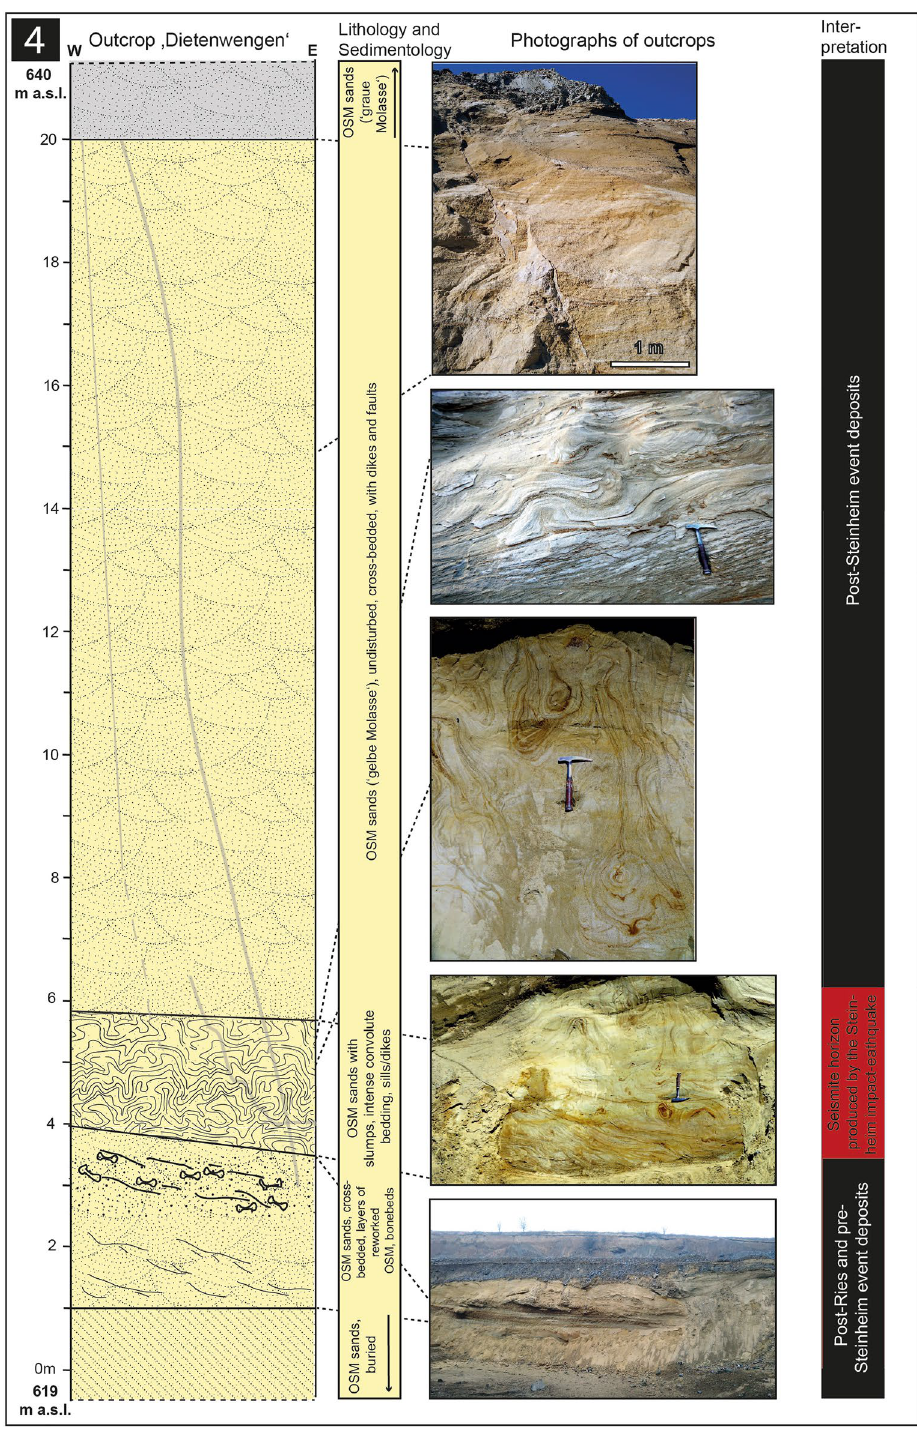
Figure 5. Schematic description of the sedimentological situation (left), outcrop photographs, and event stratigraphic interpretion of the sedimentologic succession (right) in the Dietenwengen sand and gravel pit (near Eberhardzell, ~ 2 km east of the Hochgeländ plateau; outcrop no. 4 in the text). In this outcrop, the effects of the seismic event linked with the Steinheim impact are represented by slumps, convolute bedding, and ball-and- pillow structures within the upper seismite unit (all photographs taken by V.J.S. in